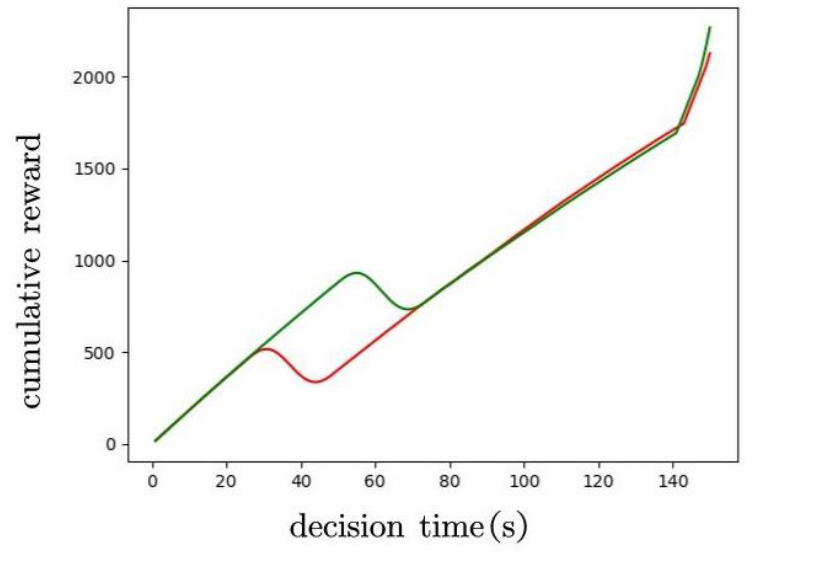
Figure 9. Change of the cumulative reward in the process of air combat.